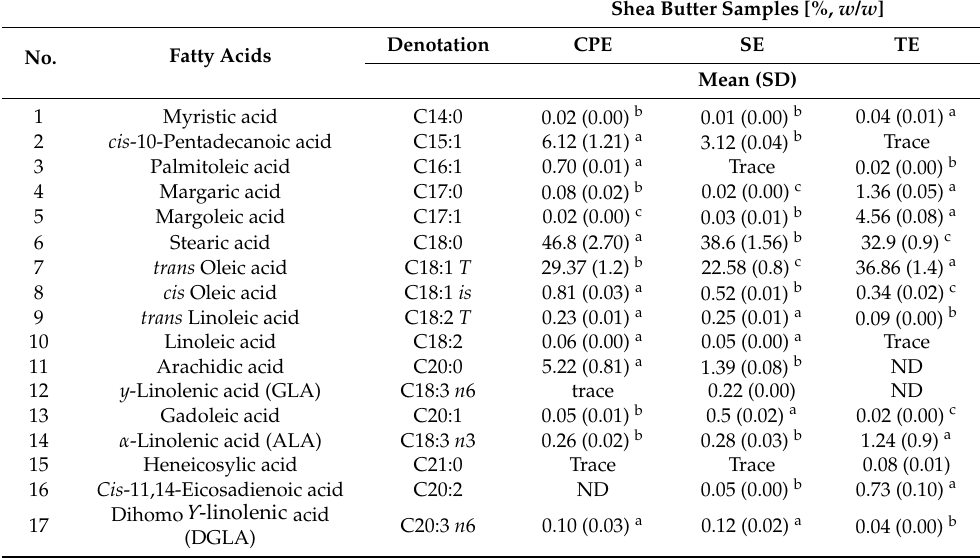
Table 2. Fatty acids